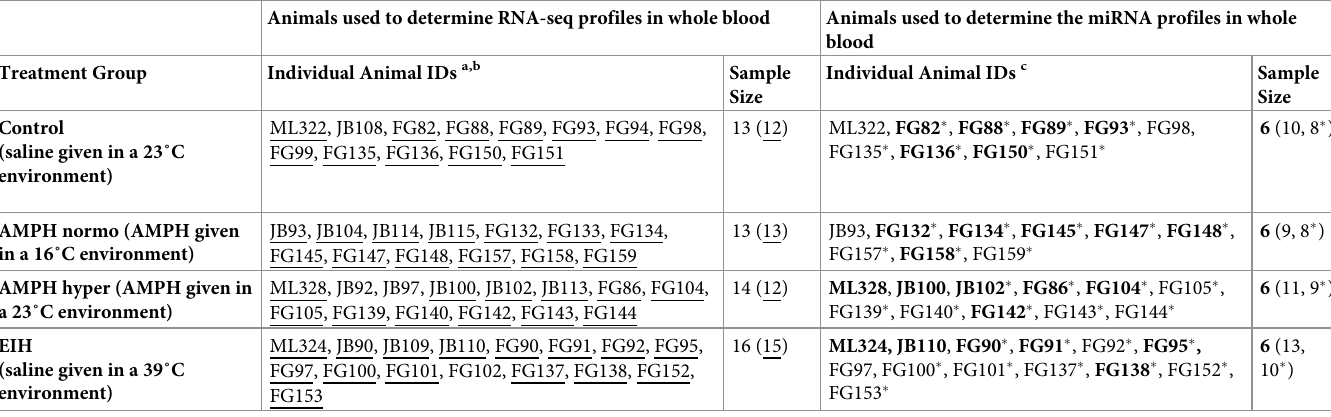
Table 1. List of animal IDs included in mRNA and miRNA analyses. Animals used to determine RNA-seq profiles in whole blood Animals used to determine the miRNA profiles in whole